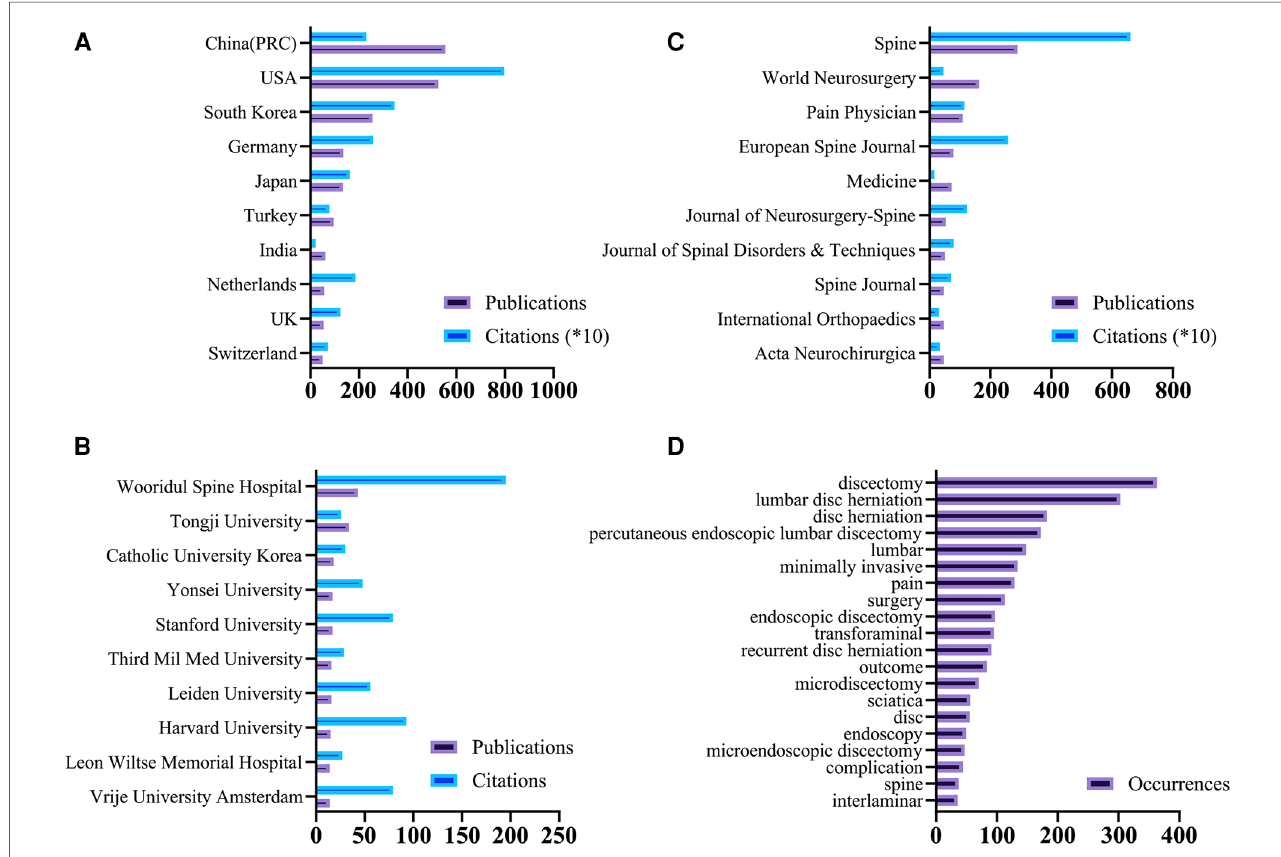
FIGURE 2 ( A ) The sum number and citation frequency of publications on discectomy from the top 10 contributing countries/regions. ( B ) The sum number and citation frequency of publications on discectomy from the top 10 contributing institutions. ( C ) The sum number and citation frequency of publications on discectomy from the top 10 contributing journals. ( D ) The top 20 keywords of occurrence frequency on discectomy.